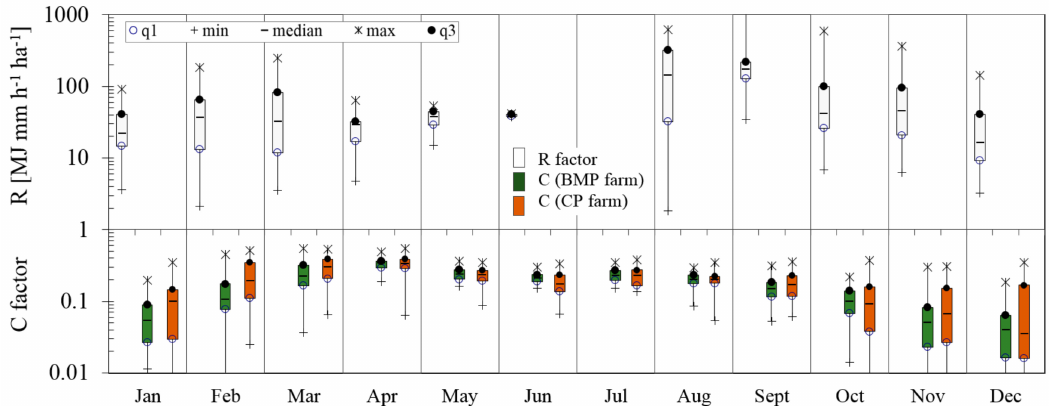
Figure 8. Box-plots of the monthly variability of R and C factors for the two investigated plots (q1 and q3 are the first and the third quartiles).